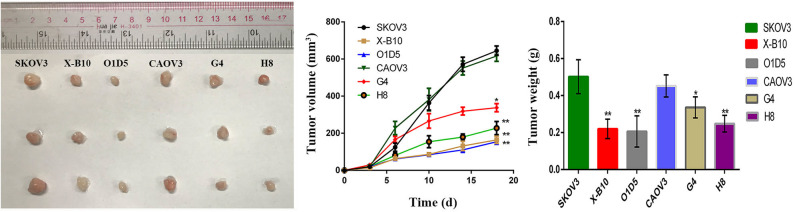
OC-2 KO inhibited the tumor growth of SKOV3 and CAOV3 cells in the xenograft model. Mice (n = 3) were subcutaneously given injection of SKOV3, CAOV3, and OC-2 KO clones (1 × 106 cells/mouse) in the right shoulder. From left to right, the stripped tumors, statistical analysis of tumor volume, and tumor weight. *P < 0.05, **P < 0.01.